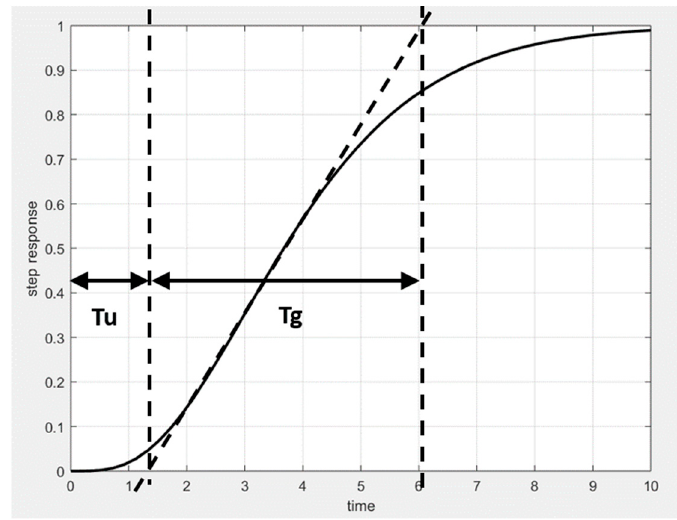
Figure 2. Step response of a PTn system. Table 1. Table values, order n and T1 of the n PT1 systems, as a function of the delay time Tu and the rise time Tn [21].